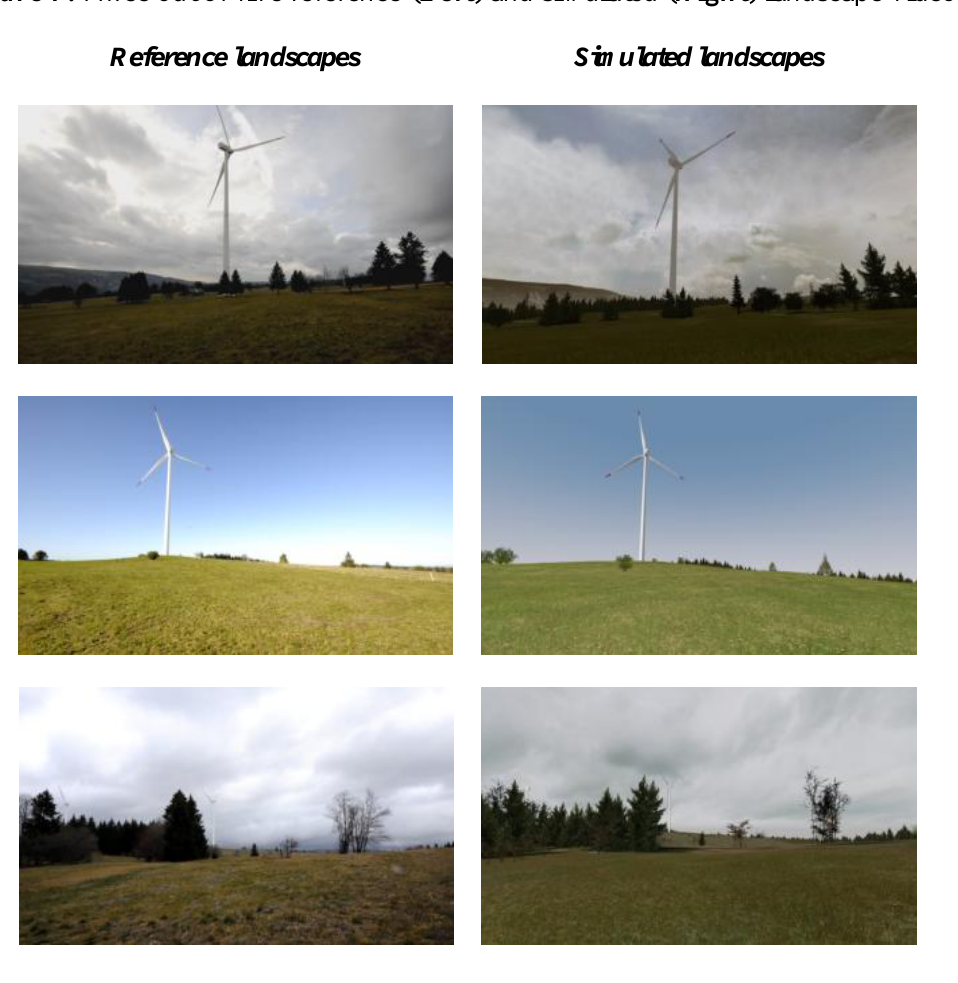
Figure 7. Three out of five reference ( Left ) and simulated ( Right ) landscape